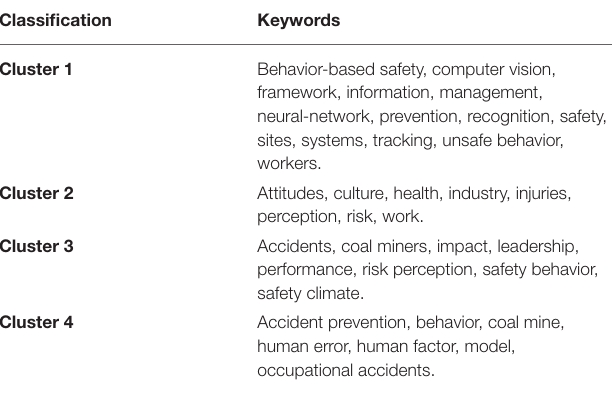
TABLE 2 | The clustering results of keywords co-word